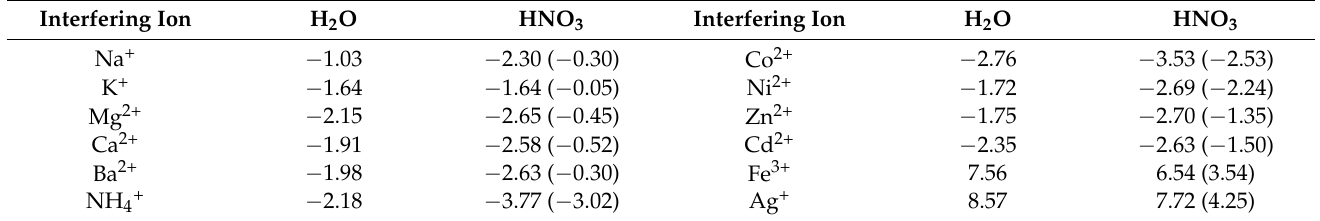
Table 4. The potentiometric selectivity, log K pot brackets refer to the GCE covered with polyaniline